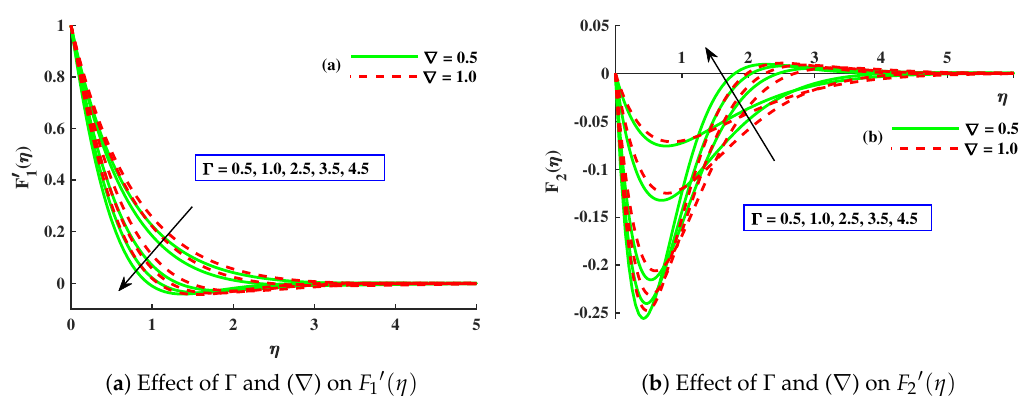
Figure 2. Curves of F 1 (cid:48) ( η ) andF 2 ( η ) along rotating parameter ( Γ ) and material parameter ( ∇ ).